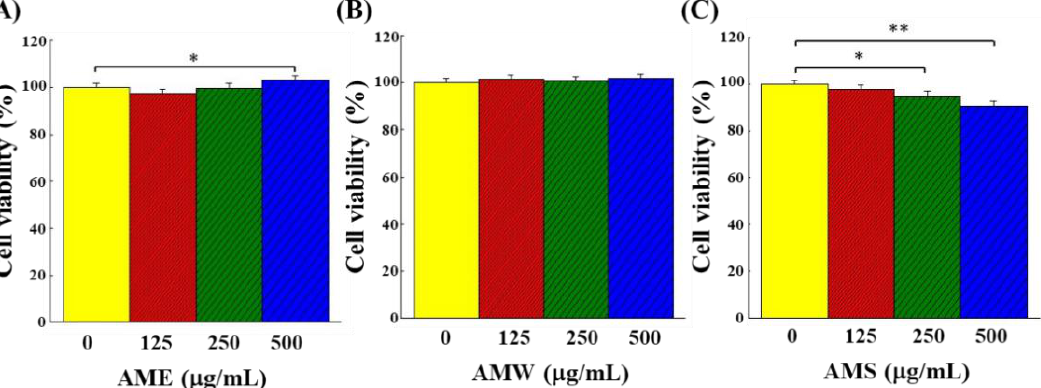
Figure 2. Cytotoxicity of the three AMf extracts on PC12 cells: ( A ) AME, ( B ) AMW and ( C ) AMS. PC12 cells were incubated for 24 h and then treated with specific extract for additional 24 h, and the viability was analyzed with an MTT kit. The vehicle group (group 0) was the PC12 cells grown only with the treatment by the sample solvent DMSO. The cell number of this group was set as 100%.